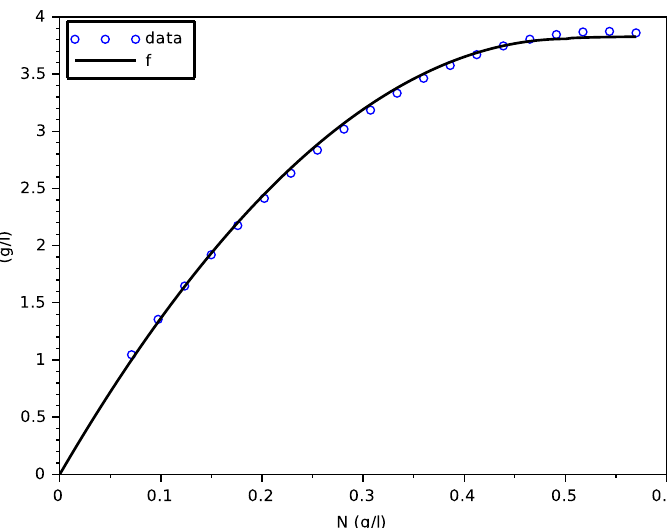
Figure 11. Result of the fitting of the function f on data from the SOFA model.